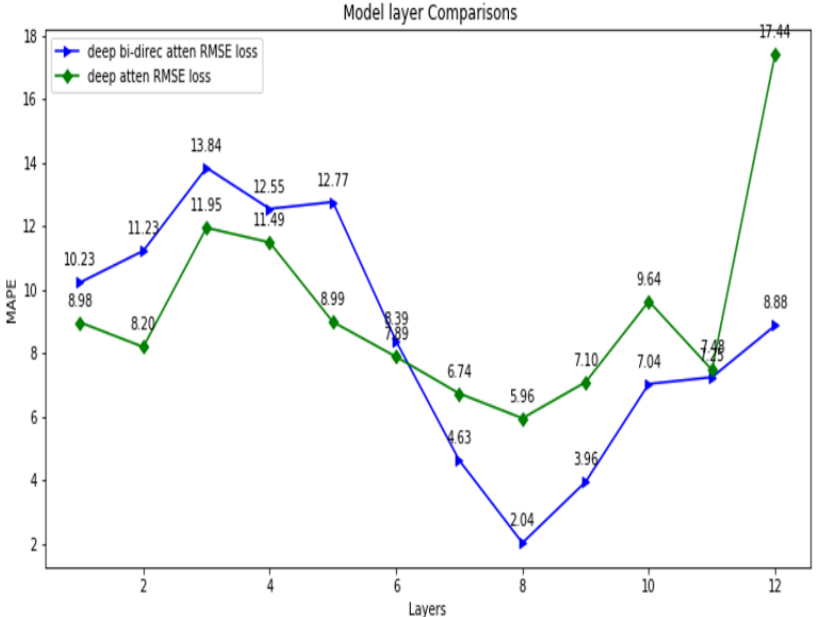
Figure 18. Comparisons between bi-directional and one-direction models with attention mechanism.